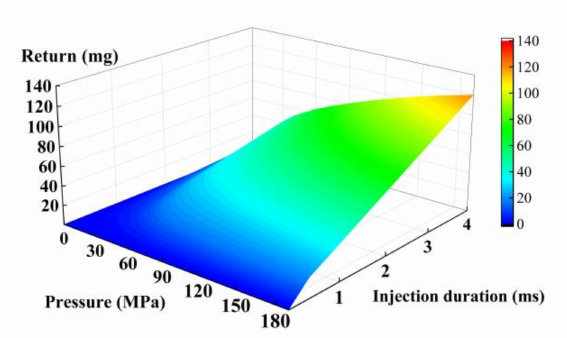
Figure 9. Characteristic data of injector